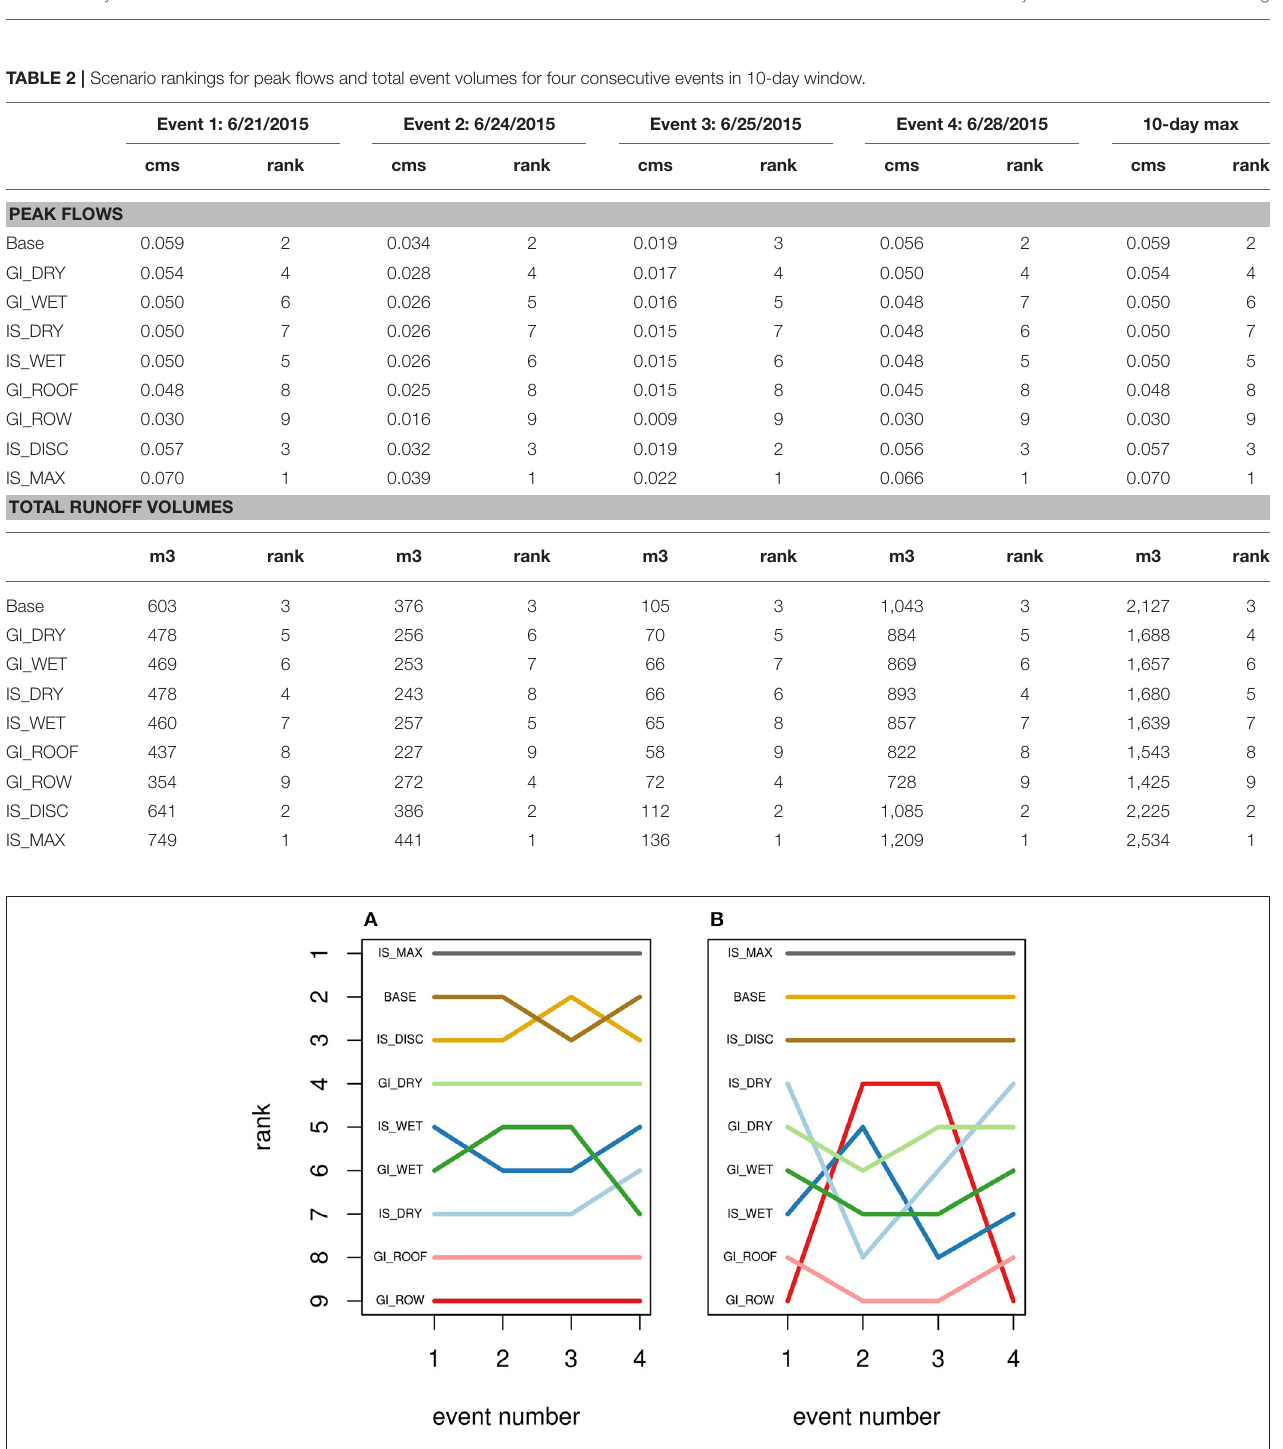
FIGURE 6 | Comparisons of magnitude rankings for (A) peak volumetric flow rates, and (B) event runoff volumes, between nine simulated scenarios, over four rainfall events in a 10-day